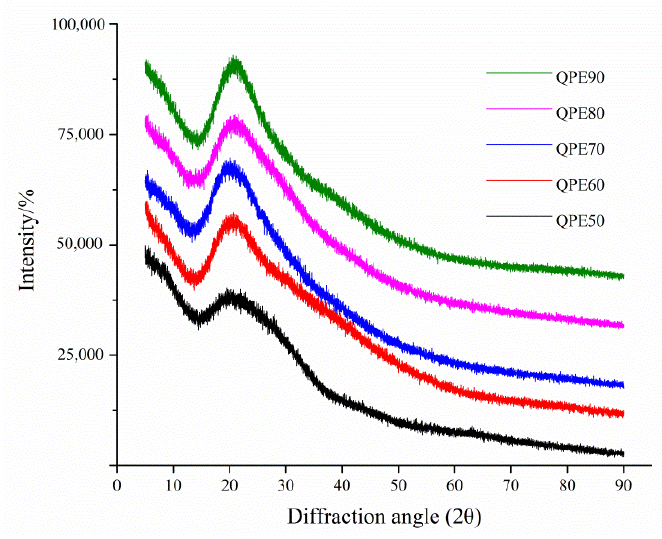
Figure 6. XRD patterns of QPs.